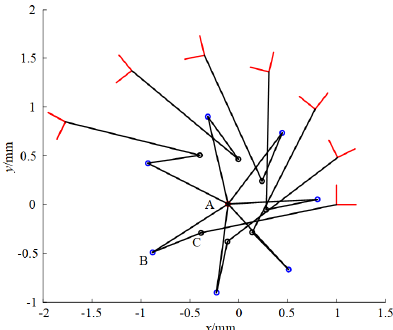
Figure 6. A planar 3R serial chain corresponding to solution